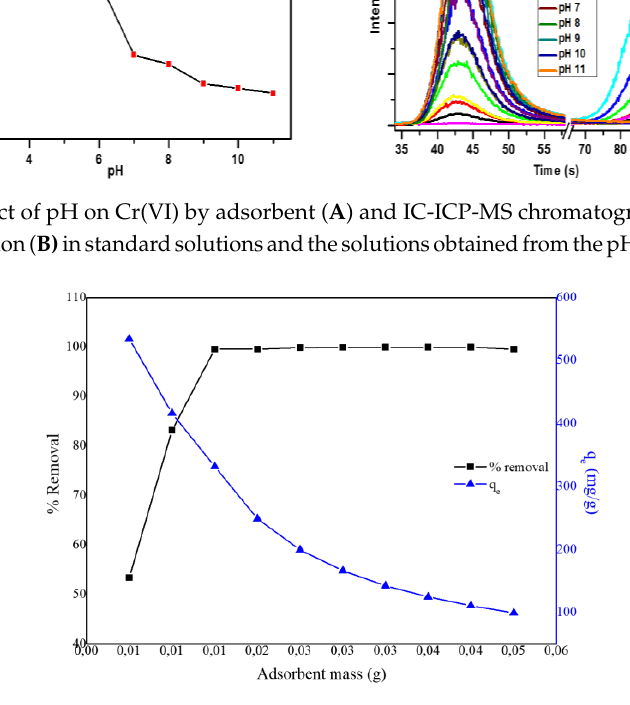
Polymers 2020 , 12 , x 10 of 17